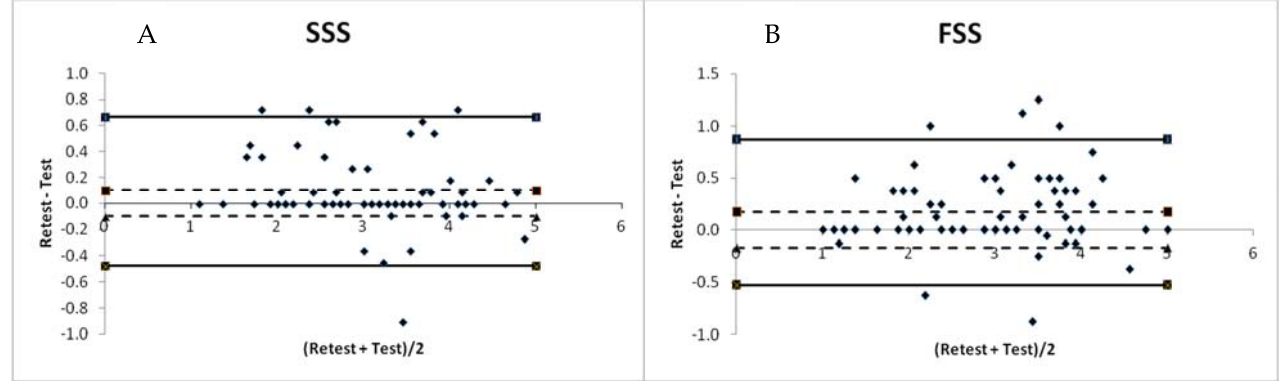
Figure 2. Bland–Altman plots of the test and retest of the symptom severity subscale (SSS) and functional status subscale (FSS) of the Boston Carpal Tunnel Questionnaire Serbian Version BCTQ SR . A : Bland–Altman plot of the test and retest of the SSS. B : Bland–Altman plot of the test and retest of the FSS. - - - - negative and positive average difference; - negative and positive 95% confidence interval.